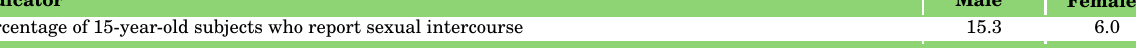
Table 40: Percentage of 15-year-olds who have had sexual intercourse in Peru Indicator Male a Female b Percentage of 15-year-old subjects who report sexual intercourse 15.3 6.0